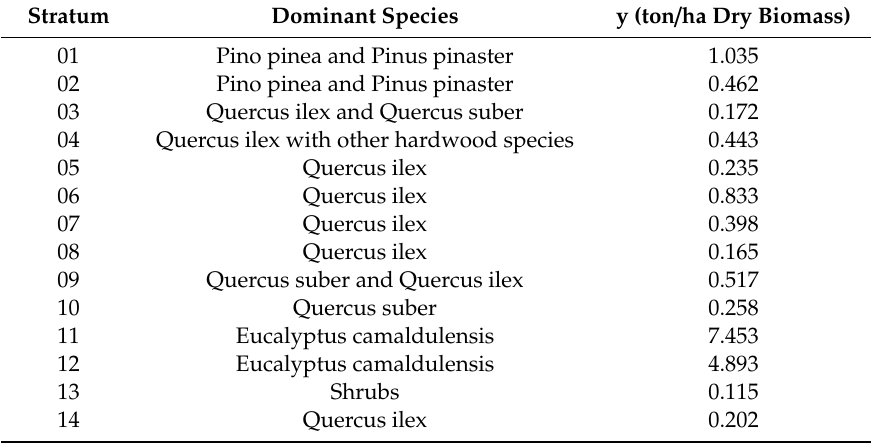
Table 4. Estimators of dry forest biomass residues according to the stratum and dominant